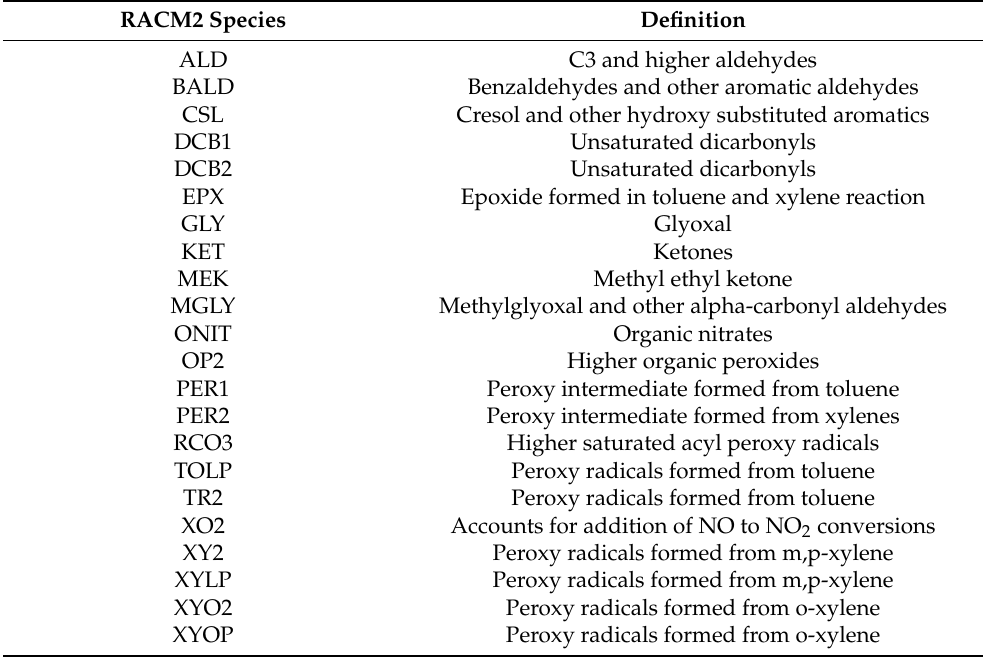
Table 4. List of RACM2 species involved in modified reactions (adapted from Goliff et al. [8]). RACM2 Species Definition ALD C3 and higher aldehydes BALD Benzaldehydes and other aromatic aldehydes CSL Cresol and other hydroxy substituted aromatics DCB1 Unsaturated dicarbonyls DCB2 Unsaturated dicarbonyls Epoxide formed in toluene and xylene reaction